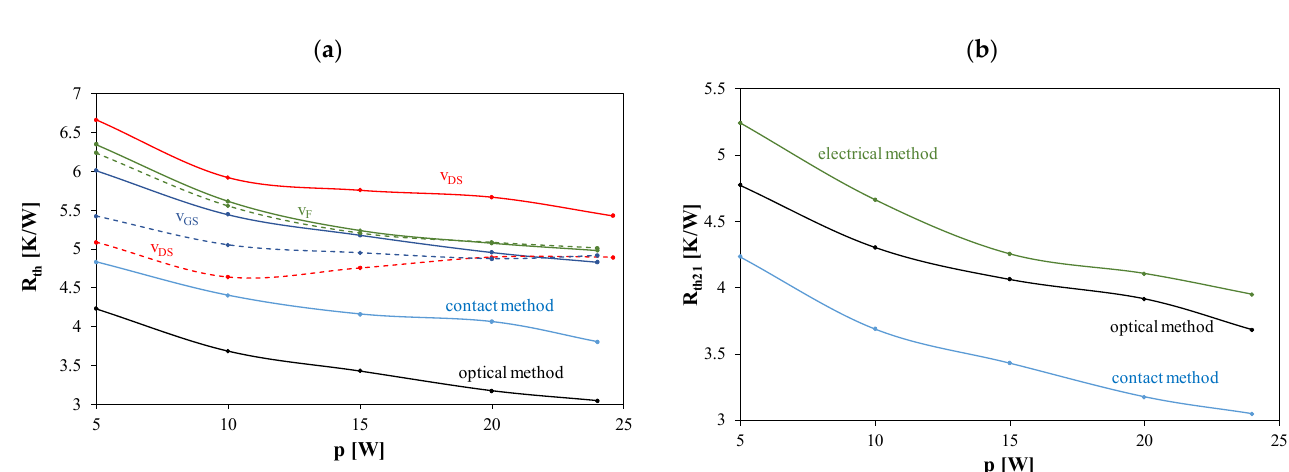
Figure 11. Measured dependences using different methods of thermal resistance of transistor M 1 ( a ) and mutual thermal resistance between the transistors on the power that was dissipated in transistor M 1 ( b ).